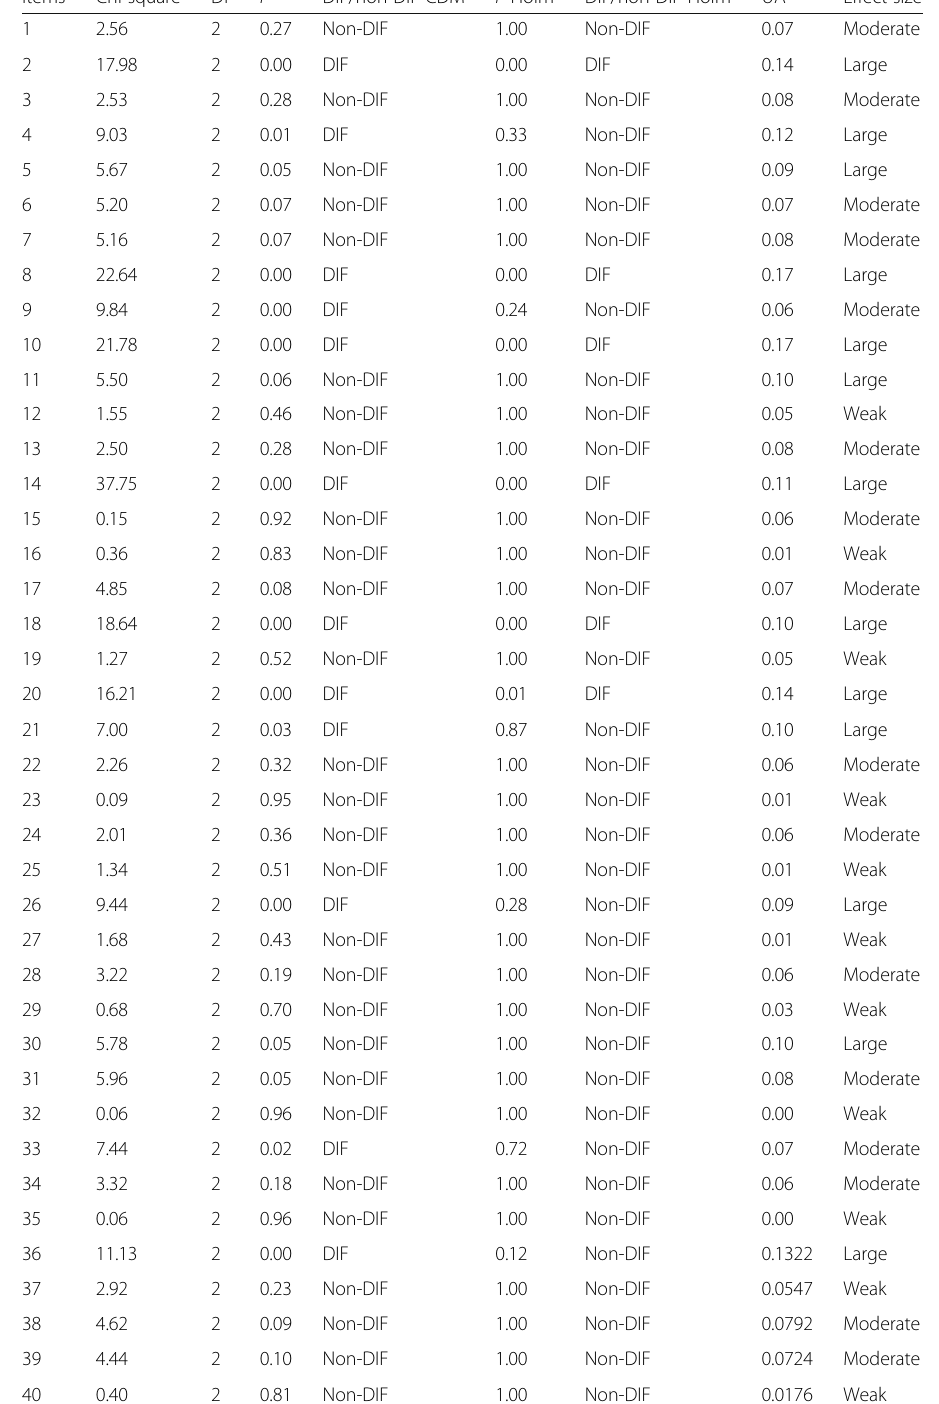
Table 9 Differential item functioning through